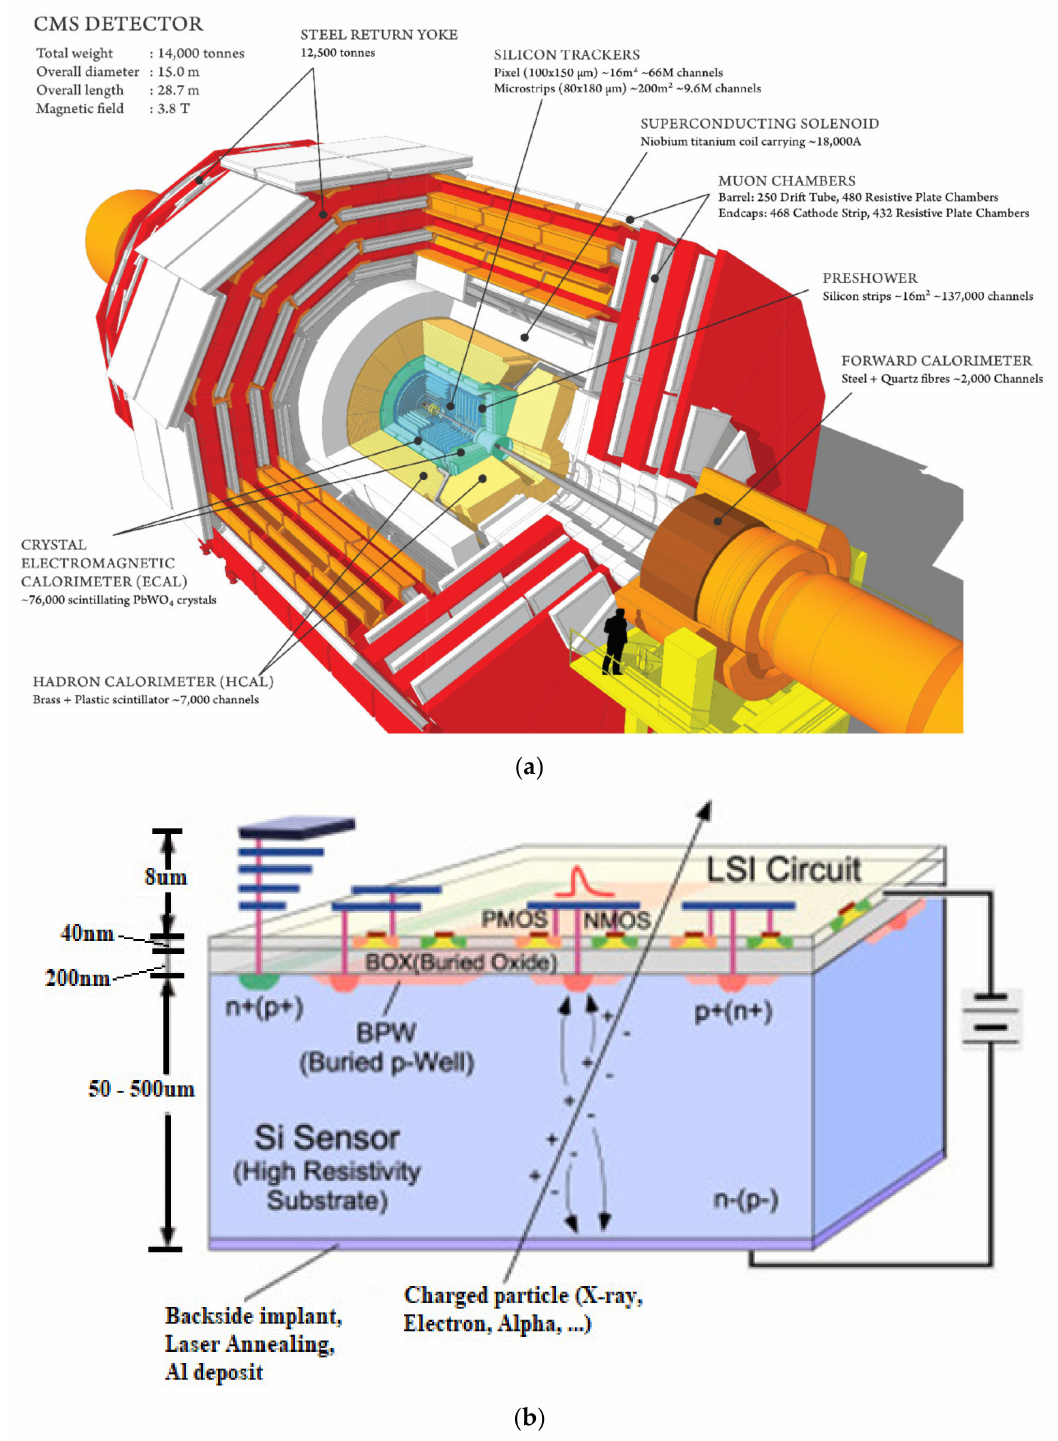
Figure 1. ( a ) The building blocks of the Compact Muon Solenoid (CMS) [5]. ( b ) Principle of operation of a silicon pixel-strip sensor